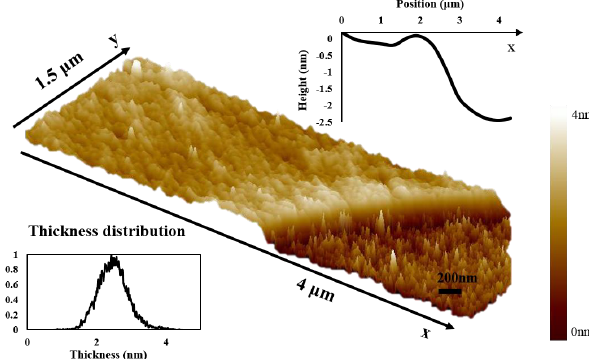
Figure 2: Atomic-force microscopy image of one of the 2.5 nm thin Figure 2 . Atomic-force microscopy image of one of the 2.5 nm thin gold films, showing the film edge on the substrate. The upper inset shows the averaged height on both sides across the edge (the mean thickness), indicating the mean thickness of the film is gold films, showing the film edge on the substrate. The upper inset about 2.5 nm. The lower inset shows the surface roughness is around 0.5 nm. shows the averaged height on both sides across the edge (the mean Optical constants for these thin film samples can be extracted from the measured RT curves in Figure 3 (a) and thickness), indicating the mean thickness of the film is about 2.5 nm. (b). In order to extract the refractive index n and extinction coefficient k , an extraction strategy is developed, The lower inset shows the surface roughness is around 0.5 which combines a multilayer transfer matrix method [28] and a two-dimensional Newton iteration method. More details of this strategy are provided in Supplementary Material . The corresponding extracted n and k values for films with different thicknesses are plotted in Figure 3 (c) and (d), respectively. Also the n and k values for bulk gold from John and Christy [27] are plotted using black dashed curves. Both n and k values for 7 nm and 30 nm are quite similar and converge to bulk values, which is expected. The case of the 2.5 nm film is quite different: the refractive index n is significantly larger, while the extinction coefficient k is much smaller than the bulk value. The increase of n and the decrease of k make the 2.5 nm gold film less like a metal. Moreover, unlike the n and k for thicker films (where both increase with wavelength), n decreases, while k increases with wavelength for 2.5 nm film in the 1 to 2 μm wavelength range.